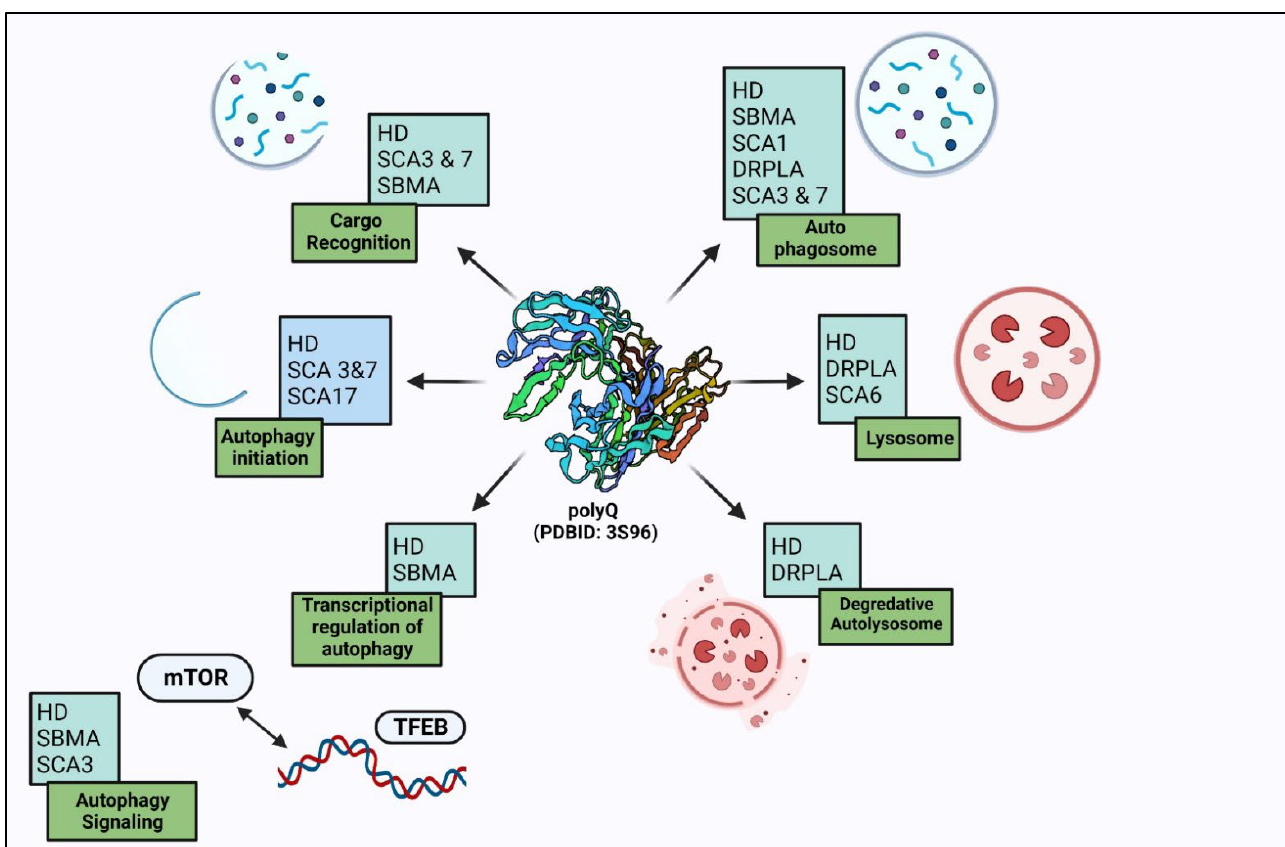
Figure 2. Autophagy dysregulation in polyglutamine disorders: autophagy degrades polyglutamine-expanded protein aggregates and also regulates them at different steps.